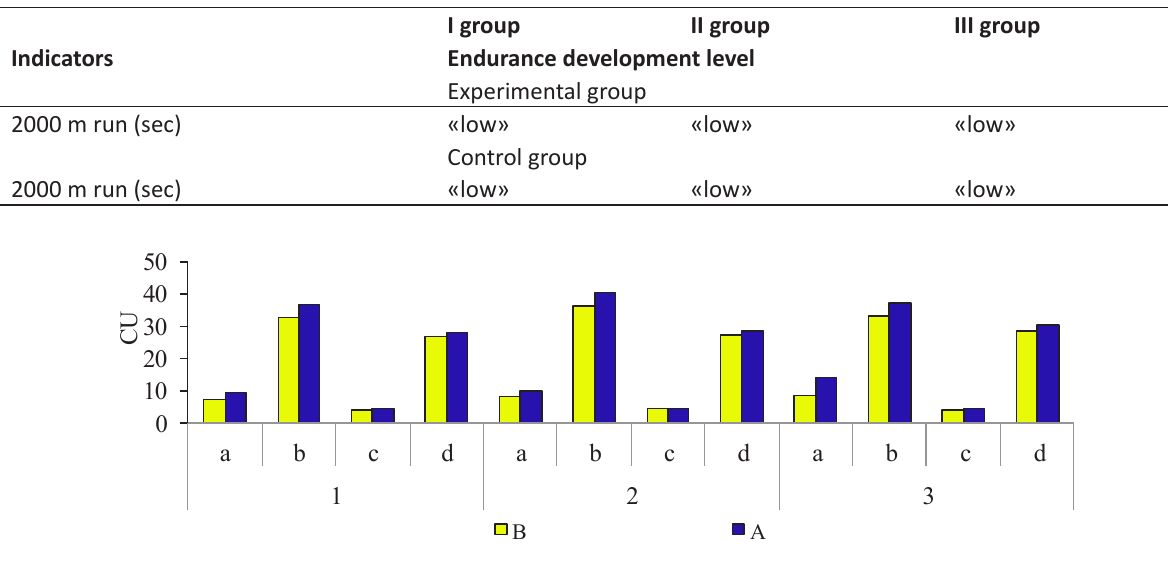
Table 3. Estimation of endurance development level in girl-students before the experiment